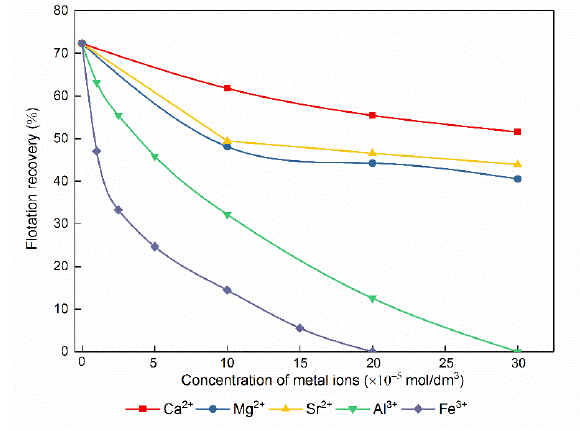
Figure 6. Influence of ion concentration on bastnaesite flotation (SHA: 5 × 10 − 4 mol/dm 3 , pH = 8).